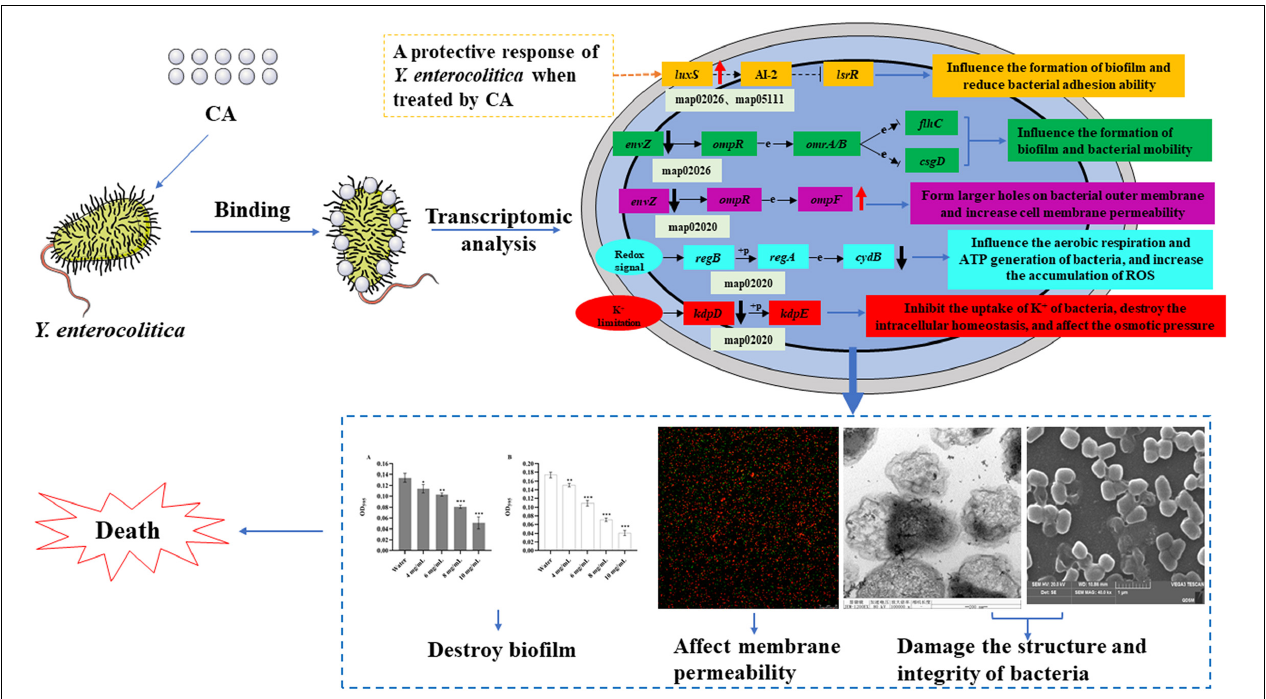
FIGURE 9 | The scheme of antibacterial mechanism of CA against Y. enterocolitica